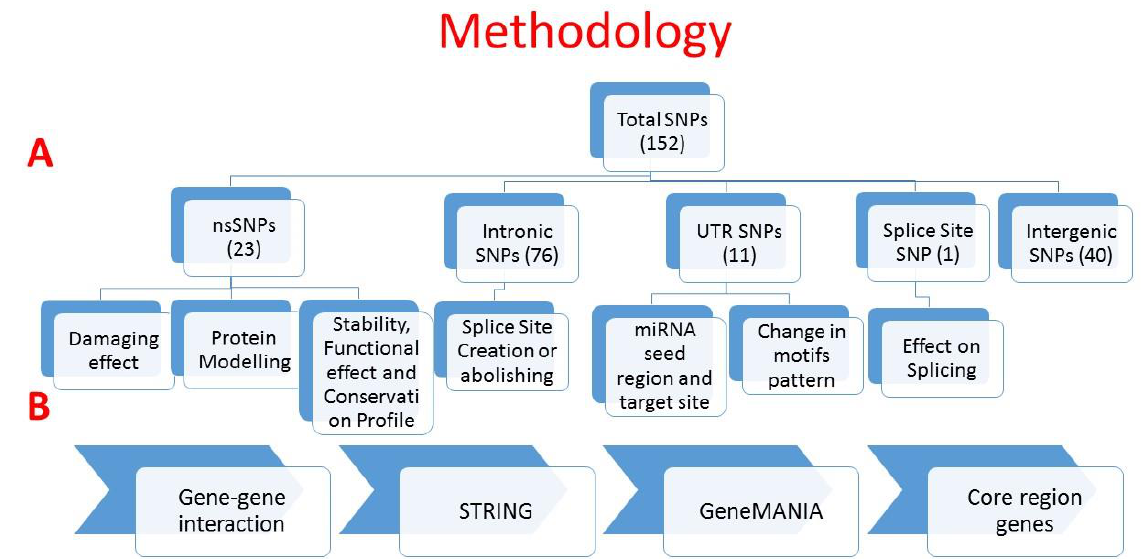
Figure 1. Workflow of the study. ( A ) SNP distribution and analysis with regard to their respective effects. ( B ) Prediction of gene–gene interactions and core region genes. This figure was generated using Microsoft PowerPoint 2016.